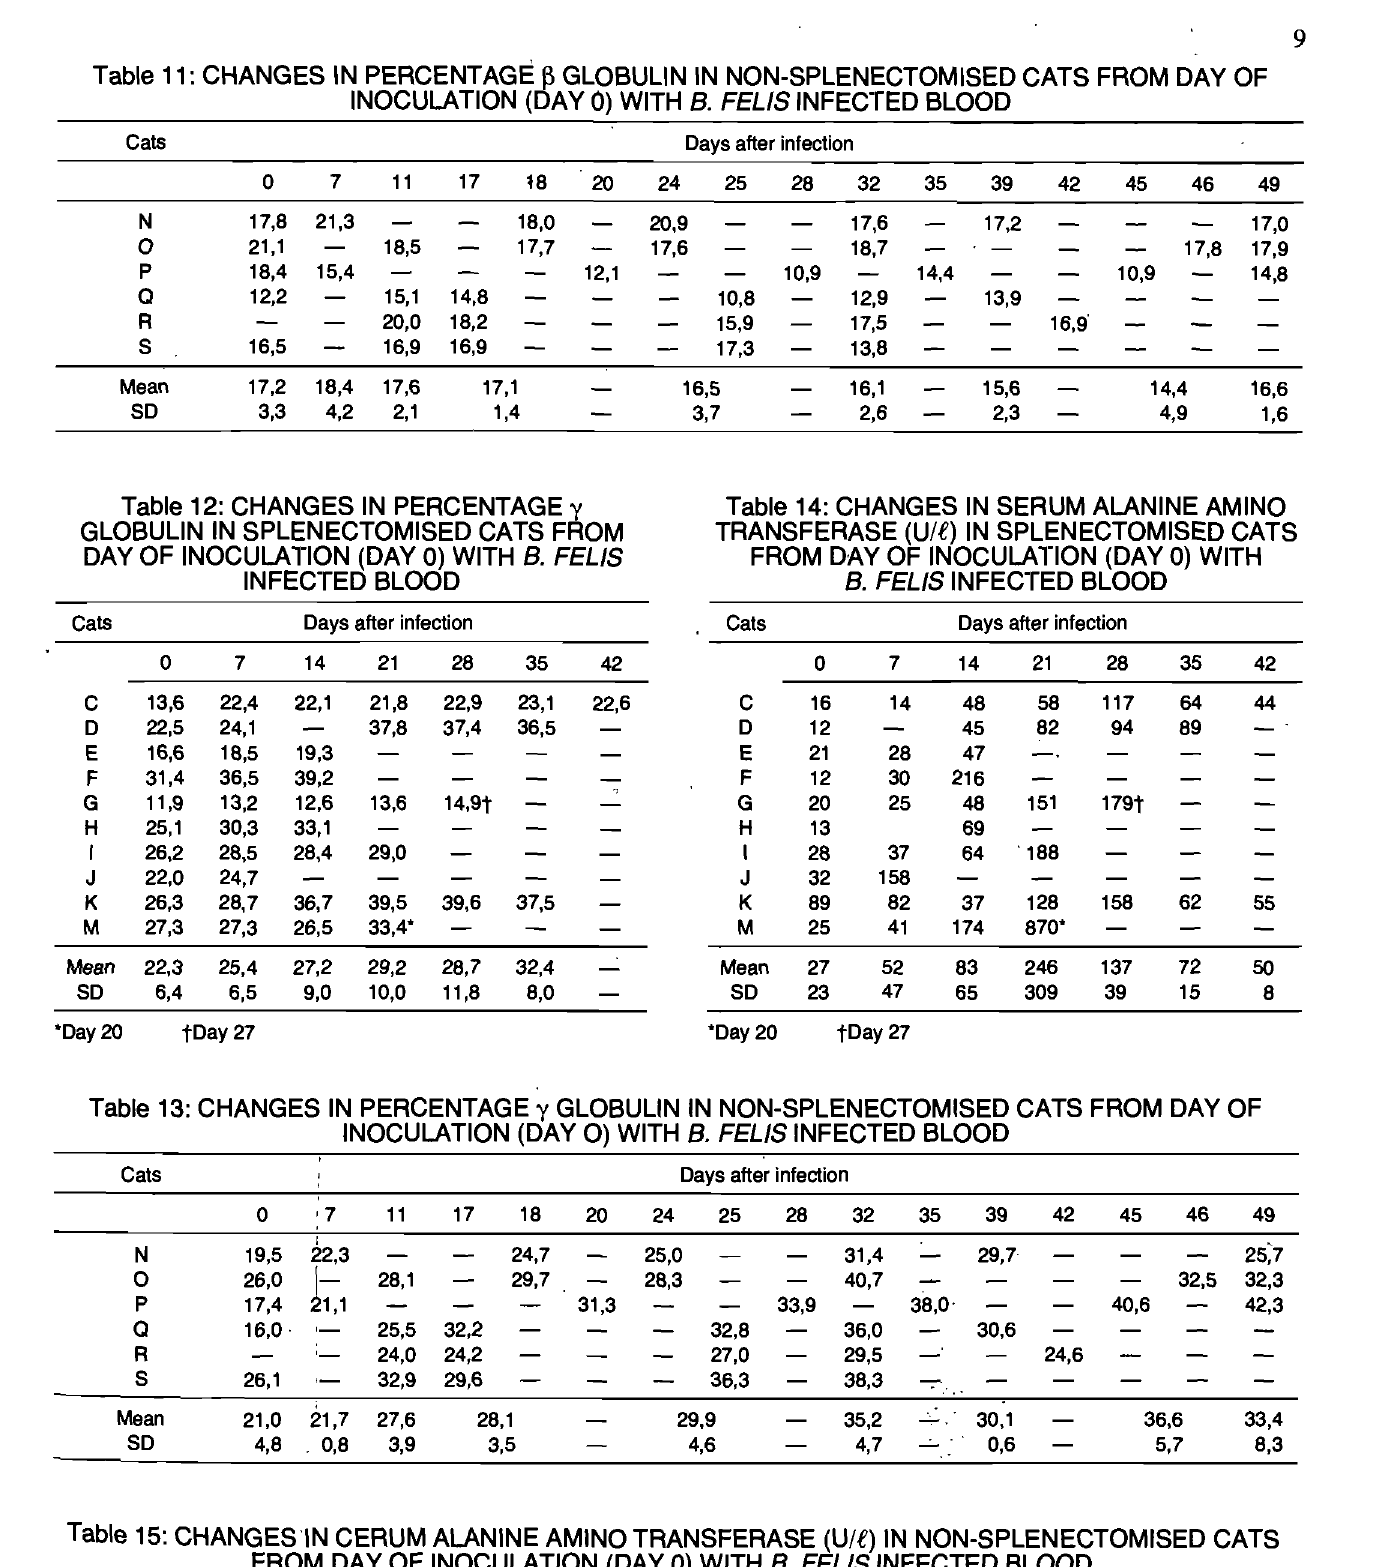
Table 15: CHANGES'IN CERUM ALANINE AMINOTRANSFERASE (Ute) IN NON-SPLENECTOMISED CATS _ FROM DAY OF INOCULATION (DAY 0) WITH B. FELIS INFECTED BLOOD Cats Days after